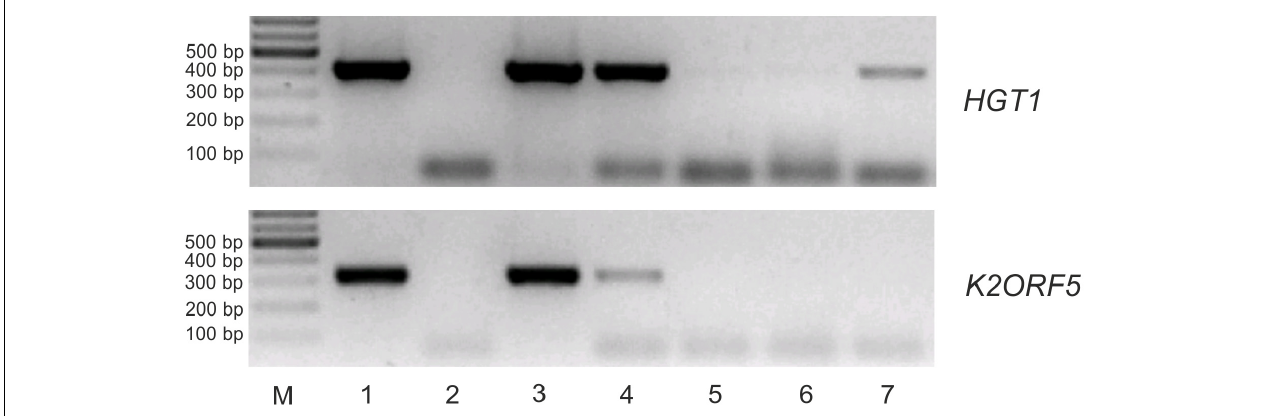
FIGURE 9 | K2ORF5 mRNA is outcompeted by cellular RNA in binding to the yeast cap-binding protein eIF4E in vitro . Electrophoretic analysis of semiquantitative RT-PCR detecting control HGT1 mRNA (upper panel) and K2ORF5 mRNA (lower panel) in samples as follows: Lane 1, glutathione-Sepharose with the bound GST-eIF4E fusion protein in the presence of excess K. lactis IFO1267 total RNA (input); lane 2, same as in line 1 but the reaction was performed without reverse transcriptase (negative control); lane 3, supernatant from the first wash step (unbound mRNA); lanes 4, 5, and 6, supernatants after the second, third, and sixth wash steps, respectively (unbound mRNA); lane 7, mRNA remaining bound on GST-S.c-eIF4E Sepharose after the sixth wash step. M, GeneRuler 100-bp DNA Ladder Plus (Thermo Scientific). PCR was performed using cDNA, Taq DNA polymerase, and the gene-specific primers listed in Supplementary Table S1 . All washing steps were performed with 70 volumes of buffer I. The initial abundances of HGT1 and K2ORF5 mRNA in the K. lactis total RNA were comparable as determined by qRT-PCR ( Supplementary Figure S3